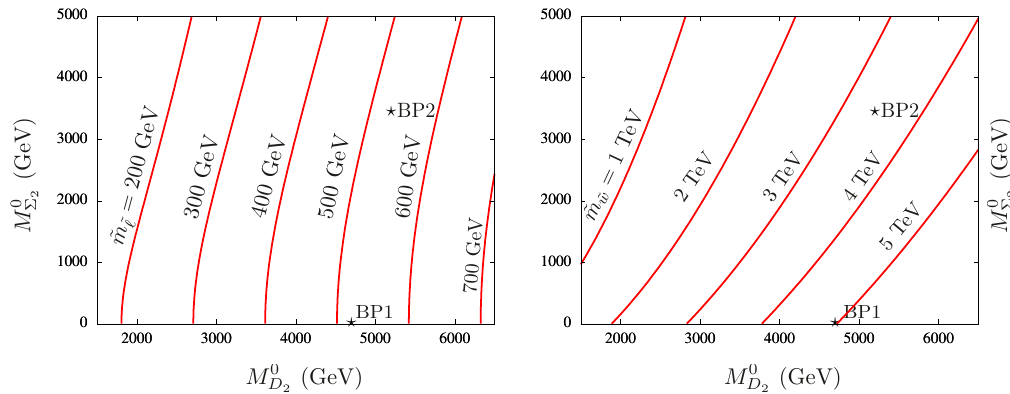
Figure 6 . Left: (cid:12)nite contribution to all SU(2) doublet sfermion masses, ~ m of the UV wino-sector masses. Right: lightest wino-sector (2 ning. For both plots, (cid:22) IR = 10 3 GeV, (cid:3) int = 10 11 GeV and (cid:11) 2 ( (cid:22) IR ) = 0 : 033. The starred point ( M 0 ; M 0 ) = (4 : 7 TeV ; 0 TeV) for BP1 and ( M 0 D 2 (cid:6) 2 (cid:12)nite mass contribution of 565 and 515 GeV respectively for all SU(2) doublets, and wino eigenvalue of 5 TeV and 3 : 4 TeV